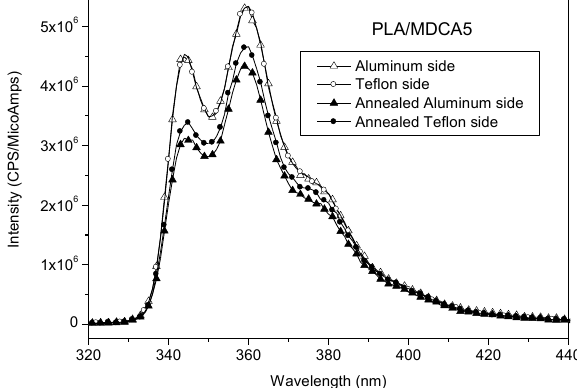
Figure 12. Fluorescence emission spectra collected from PLA/MDCA5 before and after annealing from the aluminum and Teflon sides.